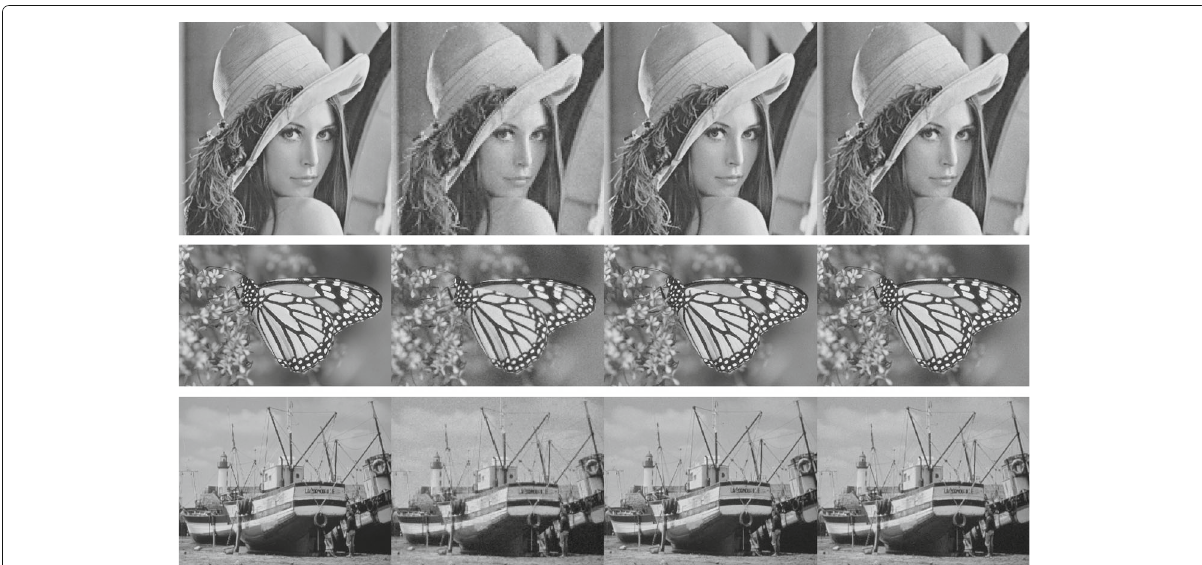
Fig. 5 Comparison of results of different reconstruction methods with different test images. From left to right: origin original HR image, reconstructed HR image using bicubic interpolation, MAP, and OSR; From top to bottom: Lenna, Monarch, and Boats